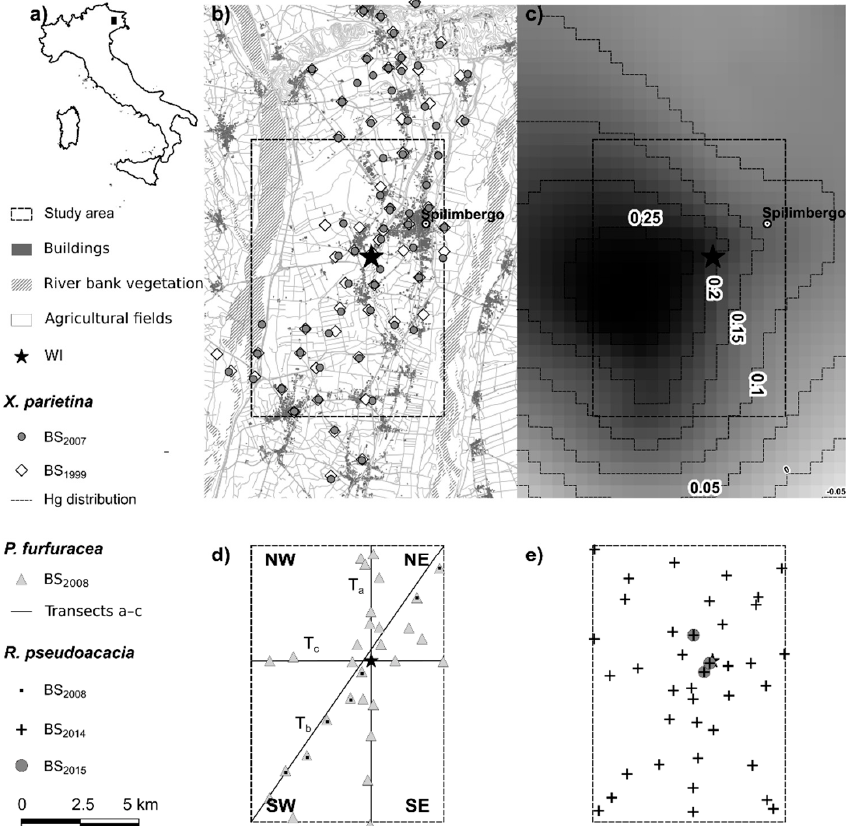
Figure 1. ( a ) Location of the study area; ( b ) cartographic details of the study area with the sampling sites of the epiphytic lichen Xanthoria parietina collected in 1999 (diamonds) and 2007 (dark grey dots); ( c ) mercury (Hg) distribution in X. parietina samples collected in 2007; ( d ) line transect design (continuous lines), exposure sites of transplants of the epiphytic lichen Pseudevernia furfuracea (light grey triangles), and sampling sites of Robinia pseudoacacia leaves (little black squares), carried out in 2008; ( e ) sampling sites of R. pseudoacacia leaves collected in 2014 (crosses) and 2015 (grey circles). BS—biomonitoring survey; WI—Waste incinerator.